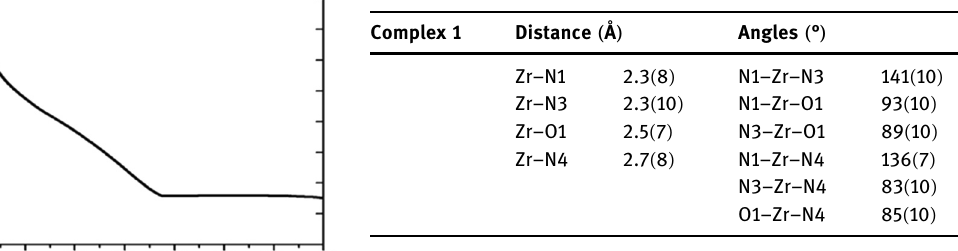
Table 2: Lengths and main binding angles in complex ( 1 )